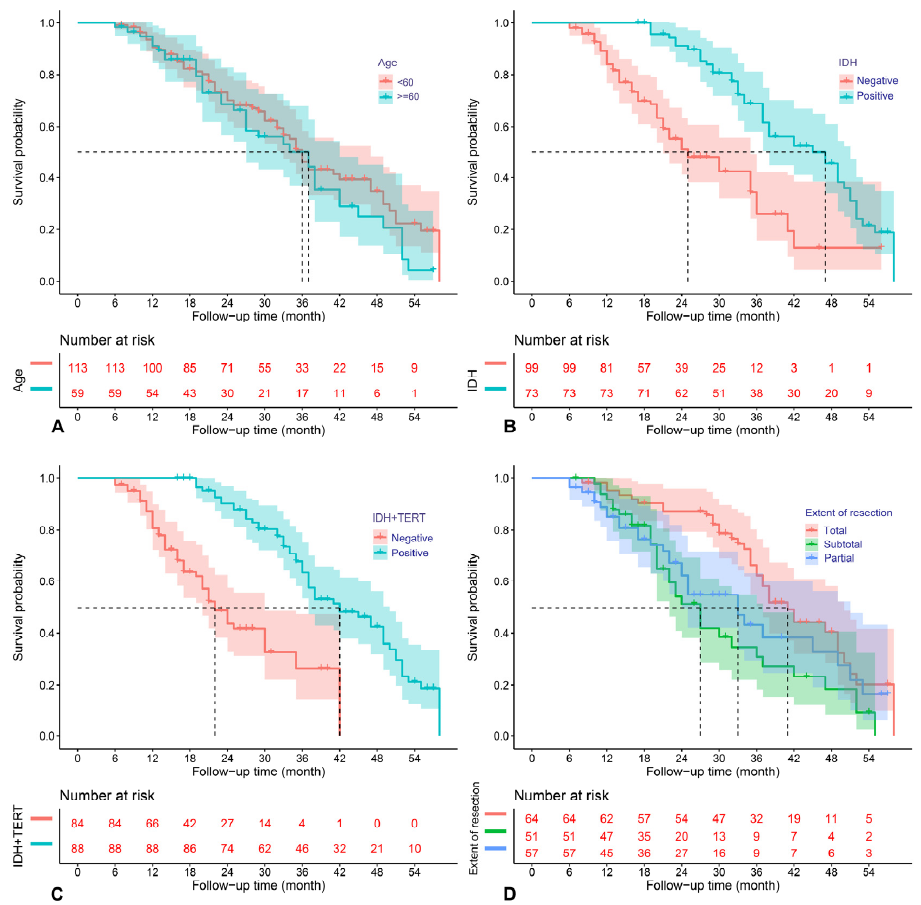
Figure 4. Kaplan–Meier survival curves for age ( A ), IDH mutation ( B ), IDH and TERT promoter co-mutation ( C ), and extent of resection ( D ), which were significantly associated with OS in the multivariable analysis.